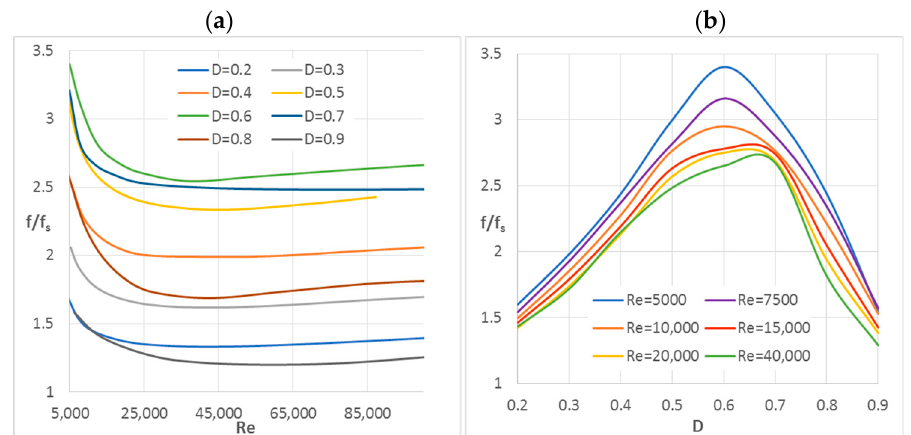
Figure 9. ( a ) the ratio f/f s ( Re ) for dimensionless diameters D ; ( b ) the ratio f/f s ( D ) for several Re numbers.